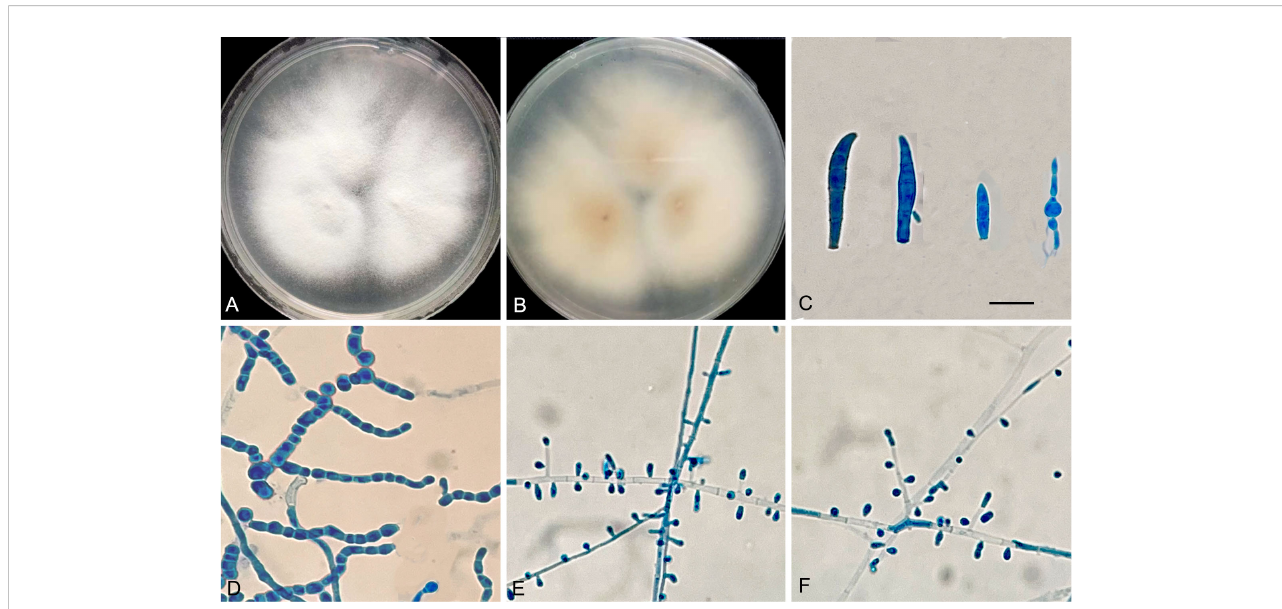
FIGURE 5 T. mentagrophytes genotype VIII (JYP 22048). Colonies on PDA 7 days at 30°C (A, B) ; Macroconidia (C) ; Chlamydoconidia (D) ; Subspherical to pyriform microconidia (E, F) ; Scale bars: 10 m